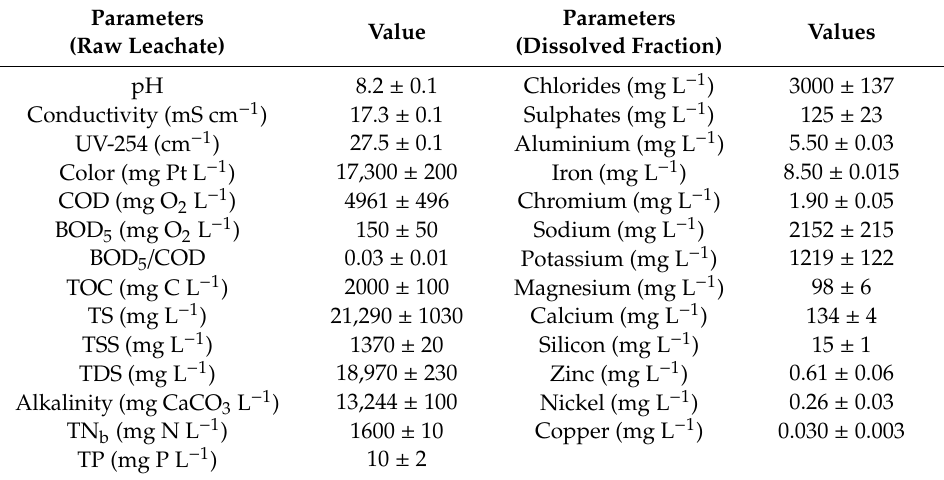
Table 2. Characteristics of the landfill leachate used in this